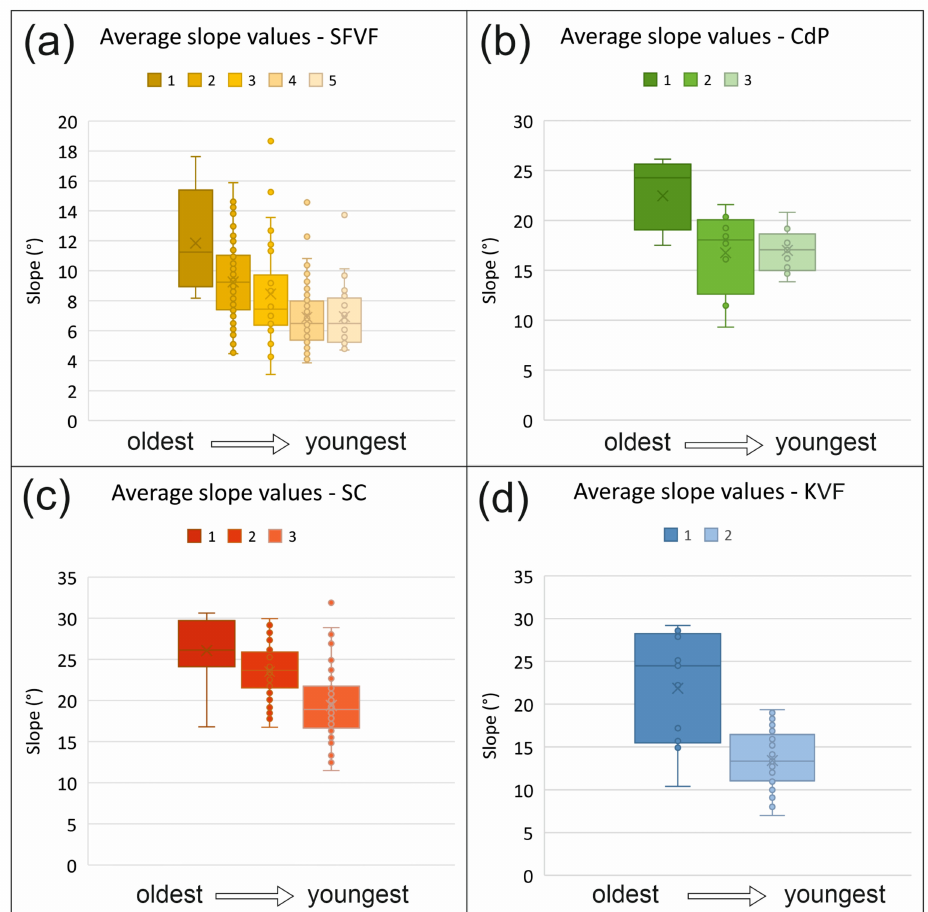
Figure 5. Boxplot diagrams of average slope values grouped by age groups (in increasing order) and areas ( a ) Chaîne des Puys, ( b ) San Francisco Volcanic Field, ( c ) Sierra Chichinautzin and ( d ) Kula Volcanic